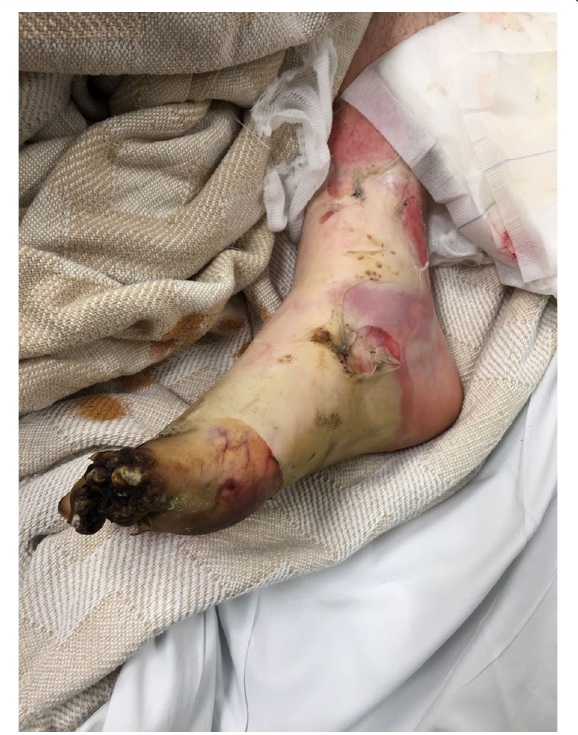
Fig. 1 Full-thickness abdominal wall electrical burn with evisceration and bowel injury